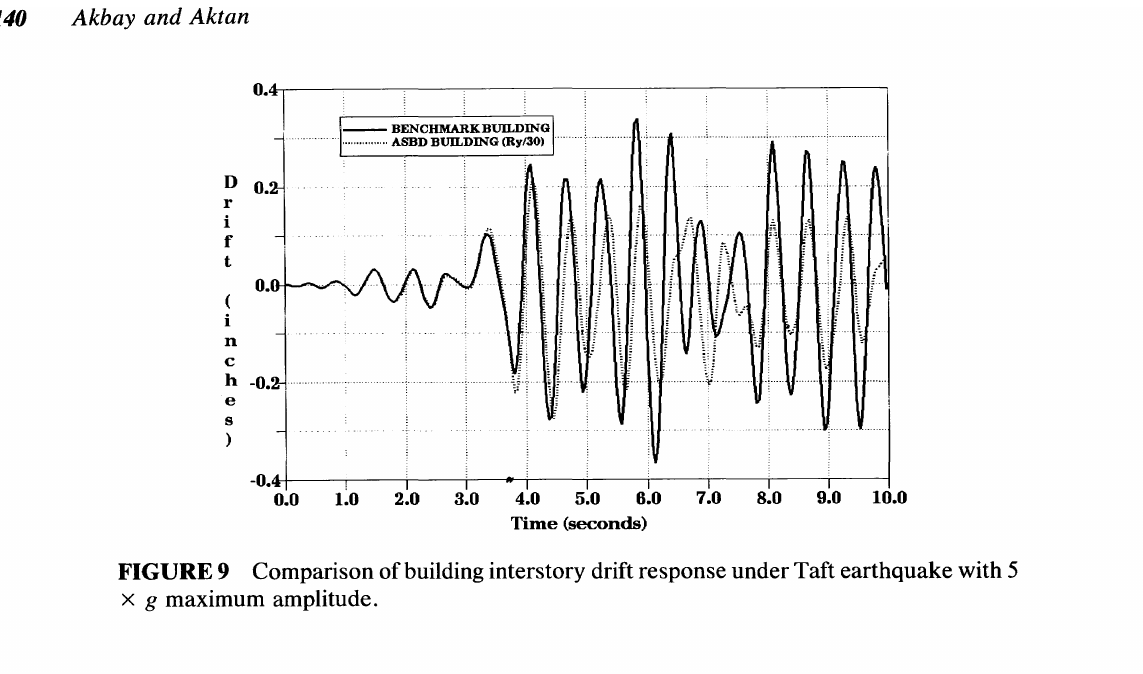
FIGURE 9 Comparison of building inters tory drift response under Taft earthquake with 5 x g maximum